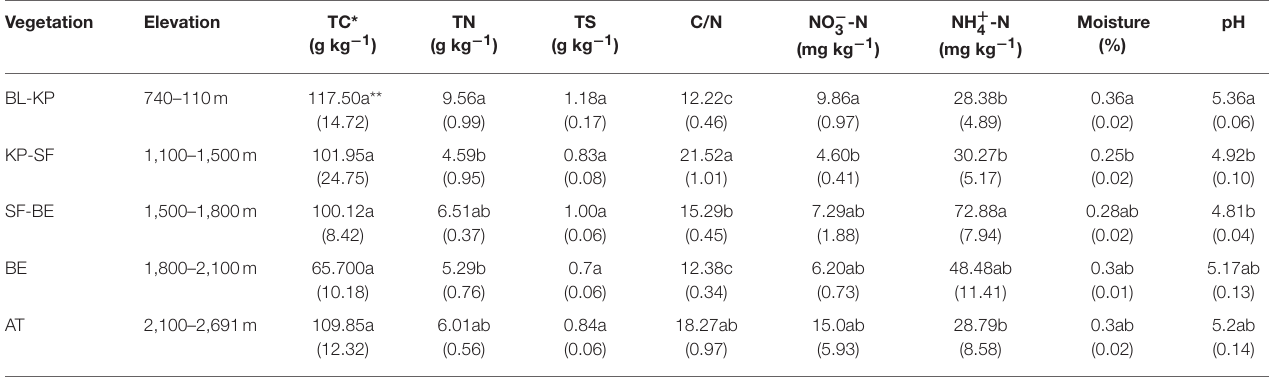
TABLE 1 | Soil properties along the northern slope of Changbai Mt. Vegetation